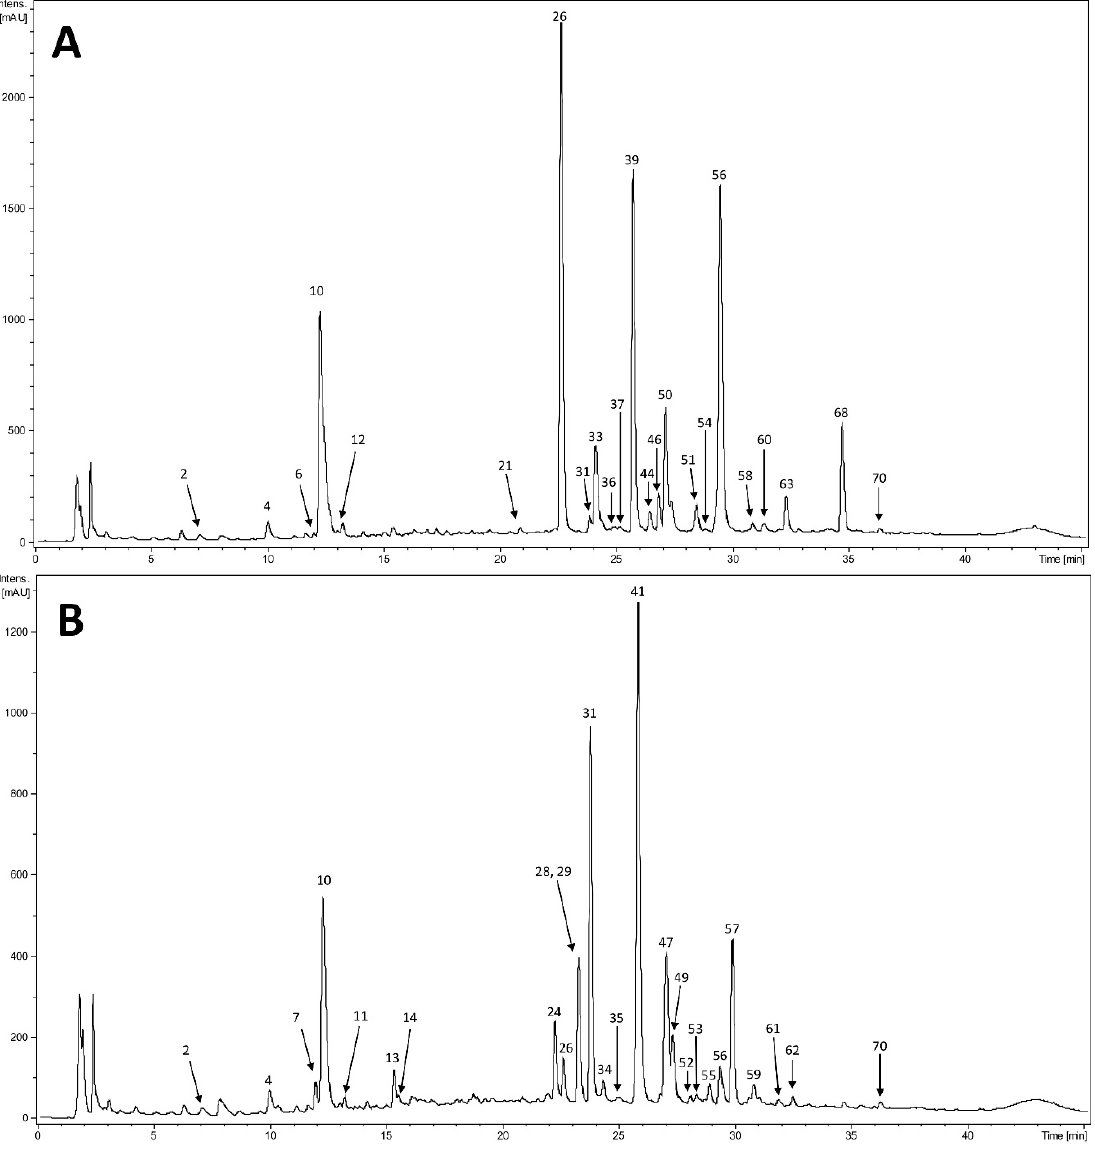
Figure 4. HPLC chromatograms at 254 nm of extracts from aerial parts of: ( A ) Arctium lappa , plant material collected from the natural position of Wola Wy ż na A; ( B ) Arctium tomentosum , plant material collected from the natural position of Strzy ż ów, Zadworze Street.